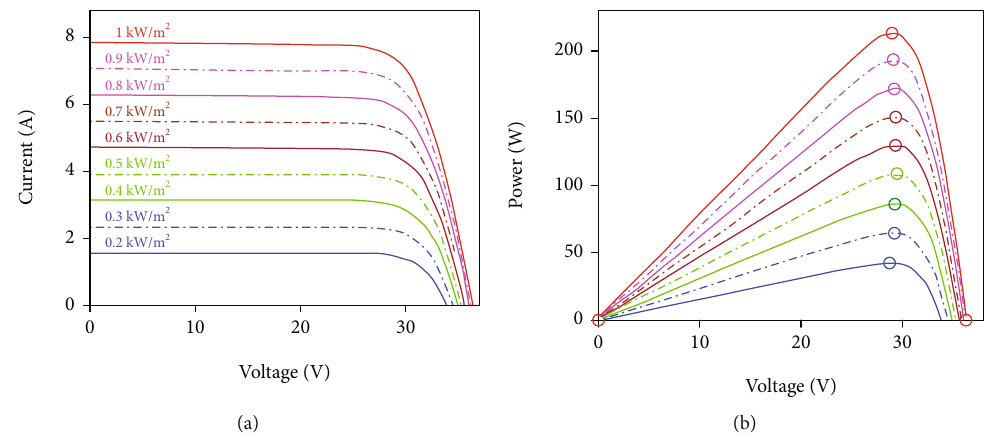
Figure 3: Characteristics of the photovoltaic module used (a) I-V and (b) P-V under G = 1 kW/m 2 and T = 25 ° C.